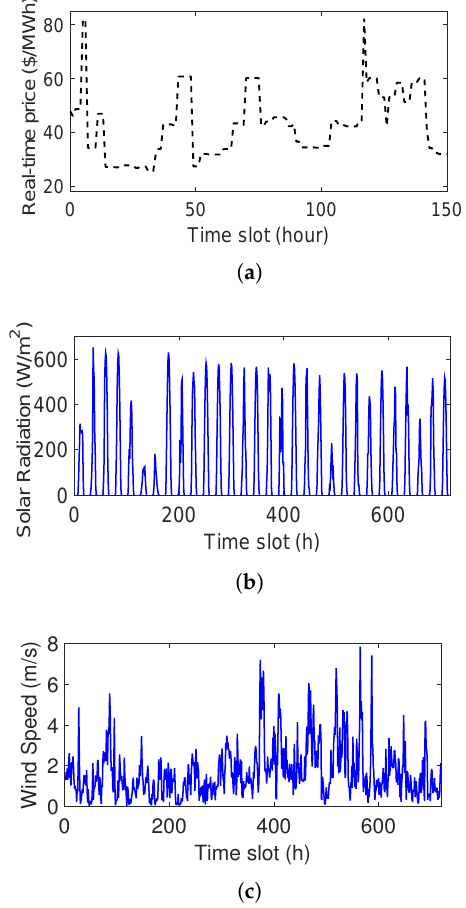
Figure 2. The dynamic real data. ( a ) electricity prices in 150 time slots from PG & E; ( b ) the dynamic solar radiation; ( c ) the dynamic wind speed.